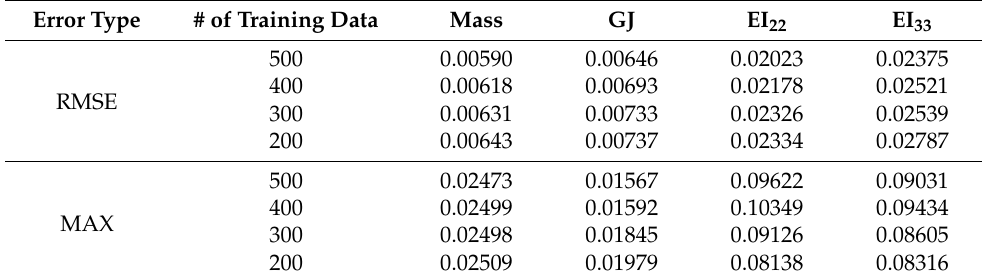
Table 5. Results of accuracy according to variation of training